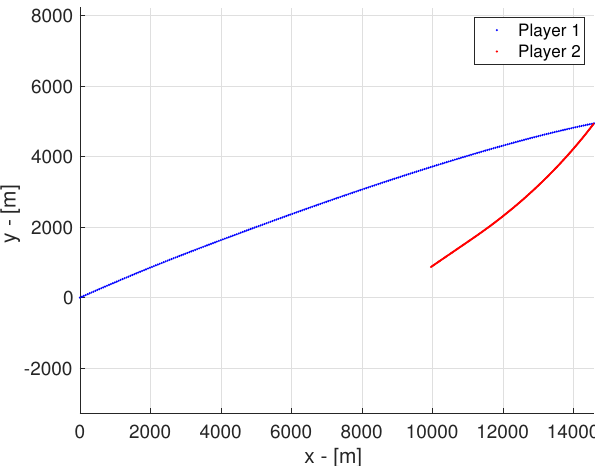
Figure 4. Trajectory of both players in the xy coordinates for one of the